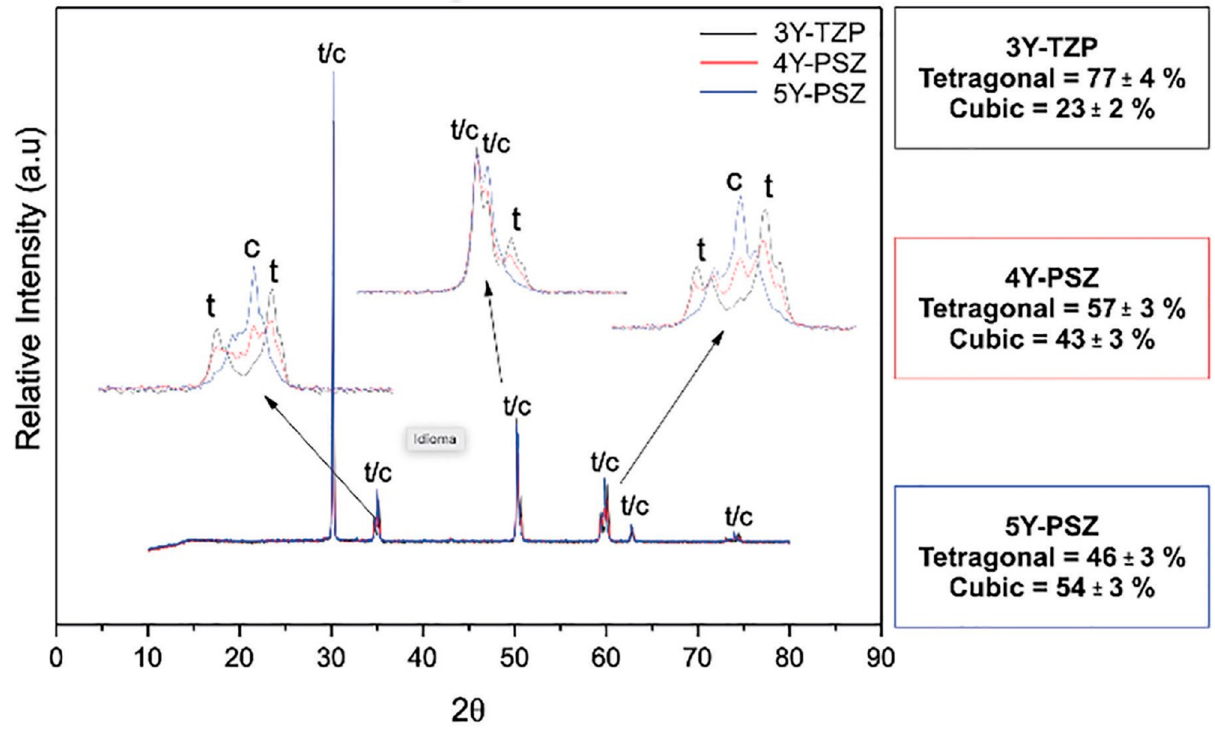
Figure 2- XRD of zirconia 3Y-TZP 2 nd generation and zirconia 4Y/5Y-PSZ 3 rd generation illustrating in the rectangle the quantification of the tetragonal and cubic phases according to Rietveld’s analysis114; Attribution 4.0 International (CC BY 4.0) Table 3- Composition, material properties, and application of zirconia